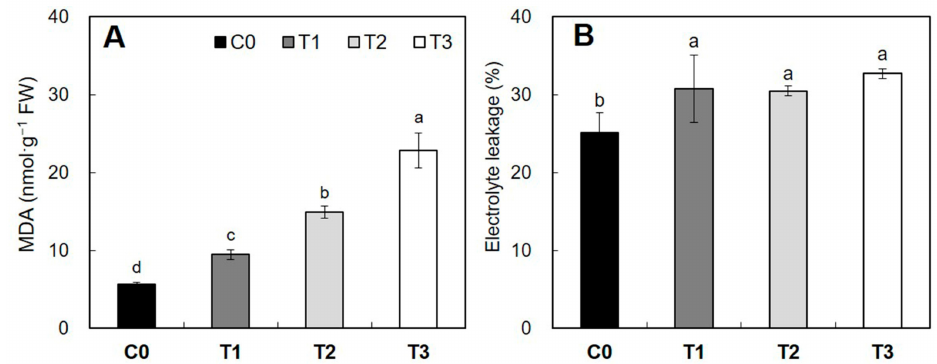
Figure 9. MDA (malondialdehyde) contents ( A ) and electrolyte leakage ( B ) in yellow-poplar leaves exposed to the natural day/night cycle (C0, black bars) and the day/night with artificial lighting cycle (T1, T2, and T3 denote dark gray bars, light gray bars, and white bars, respectively). Data indicate mean ± SD ( n = 5). Different lowercase letters on the bars indicate significant differences among treatments (Tukey’s test after one-way ANOVA).